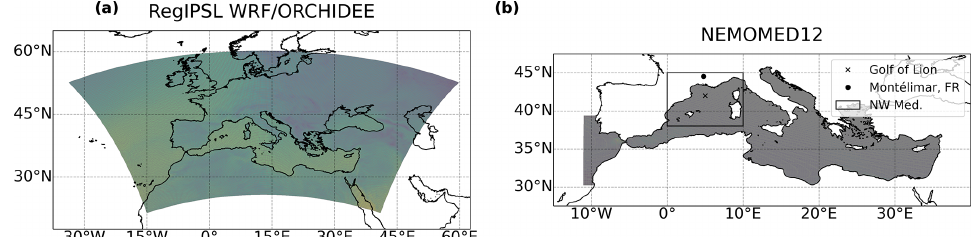
Figure 1. The domains of both the WRF domain from the RegIPSL coupled WRF/ORCHIDEE simulation within the Med-CORDEX framework (a) and the NEMOMED12 configuration domain (b) . The region of interest, the NW Med., is outlined by the box. This region is later used in Fig. 7. The location used to study the temporal development of deep convection in the GOL is at 42 ◦ N, 5 ◦ E, and the other location, used in conjunction with the aforementioned point to determine mistral events, is Montélimar, France, at 44.56 ◦ N, 4.75 ◦